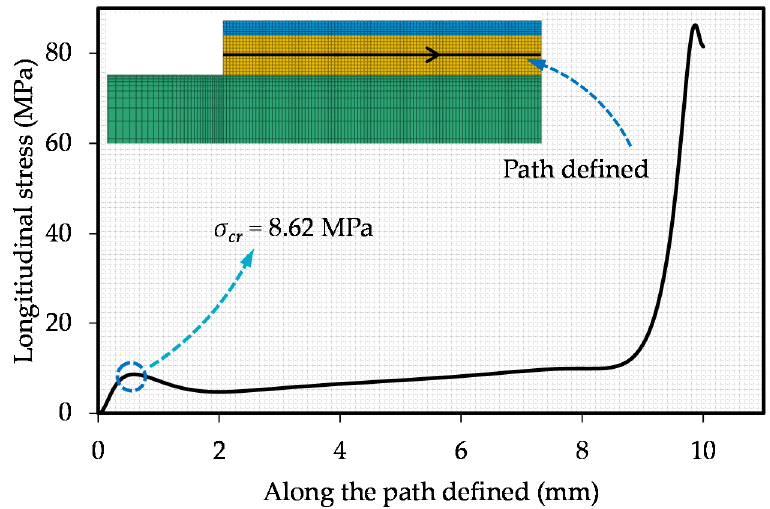
Figure 6. Longitudinal stress distribution along the path defined in the mid-plane of the adhesive layer for the present experimental series— L 1 = 10 mm.